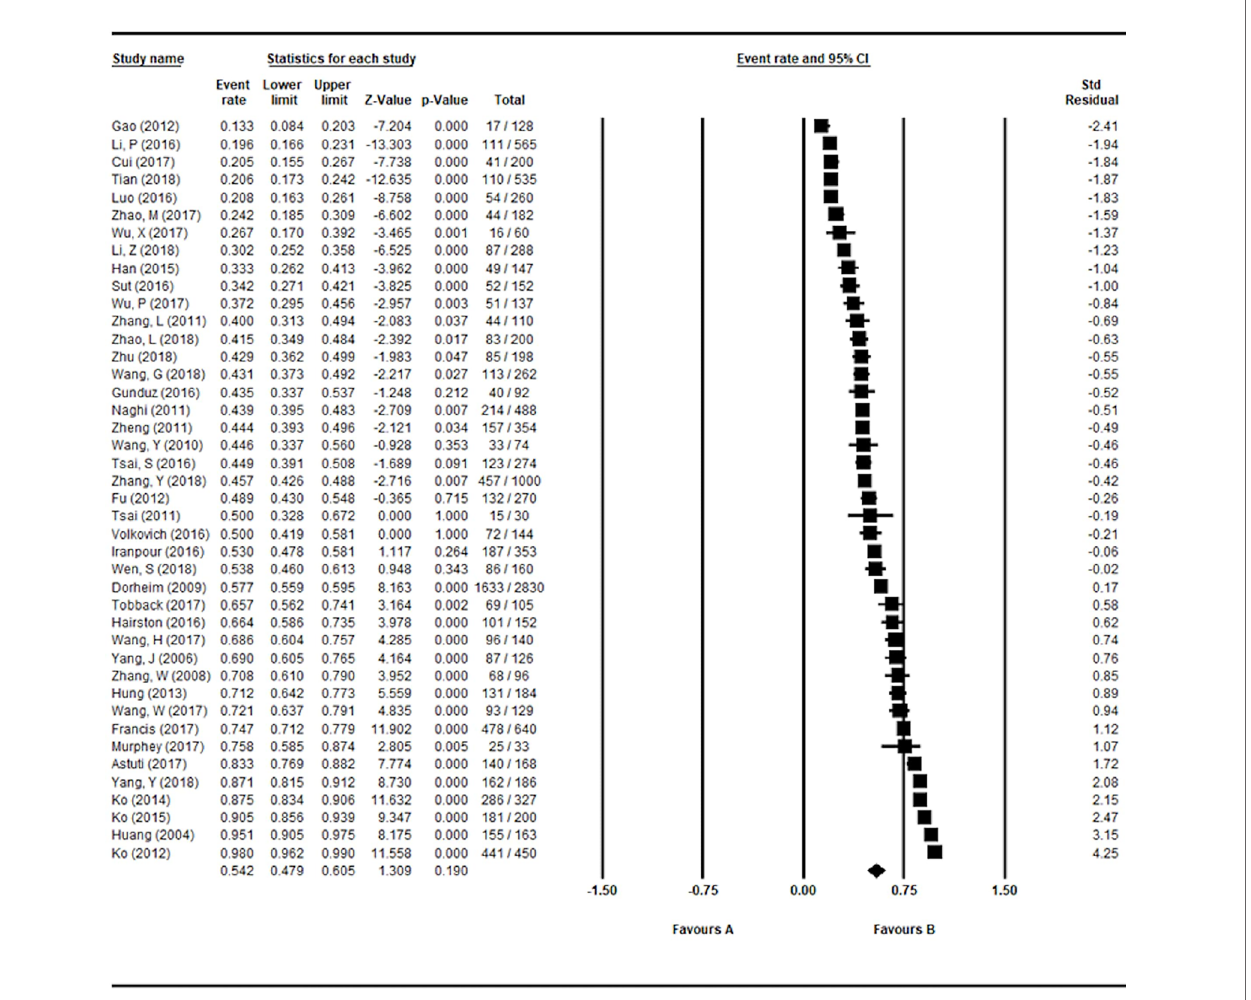
FIGURE 2 | Forest plot of prevalence of poor sleep quality.